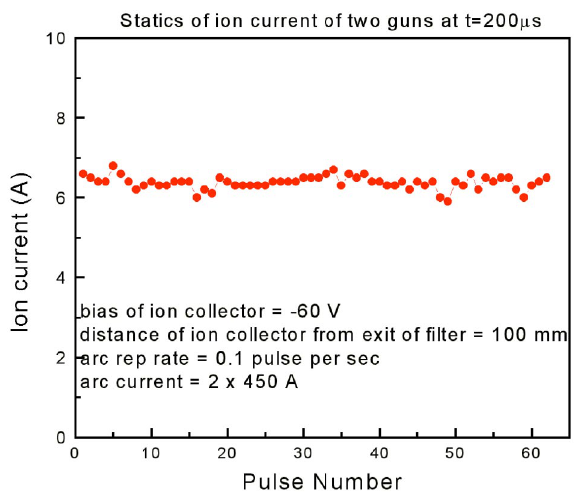
FIG. 25. (Color) Ion current signal from the two cathode-arc plasma sources, each operating with 450 A arc current and fed by the same pulse-forming